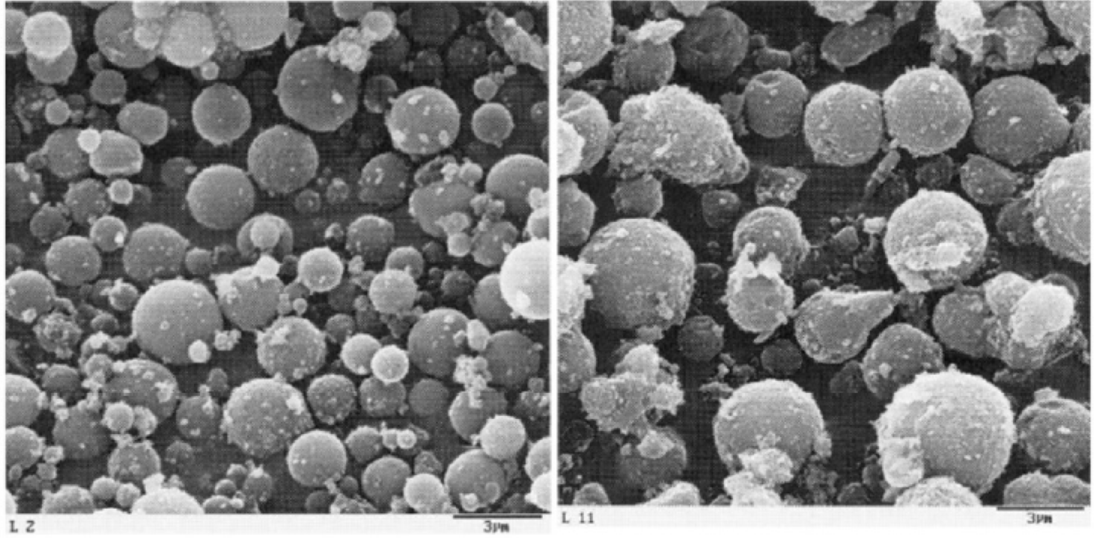
Figure 2. SEM photograph of silica nanoparticles [76].